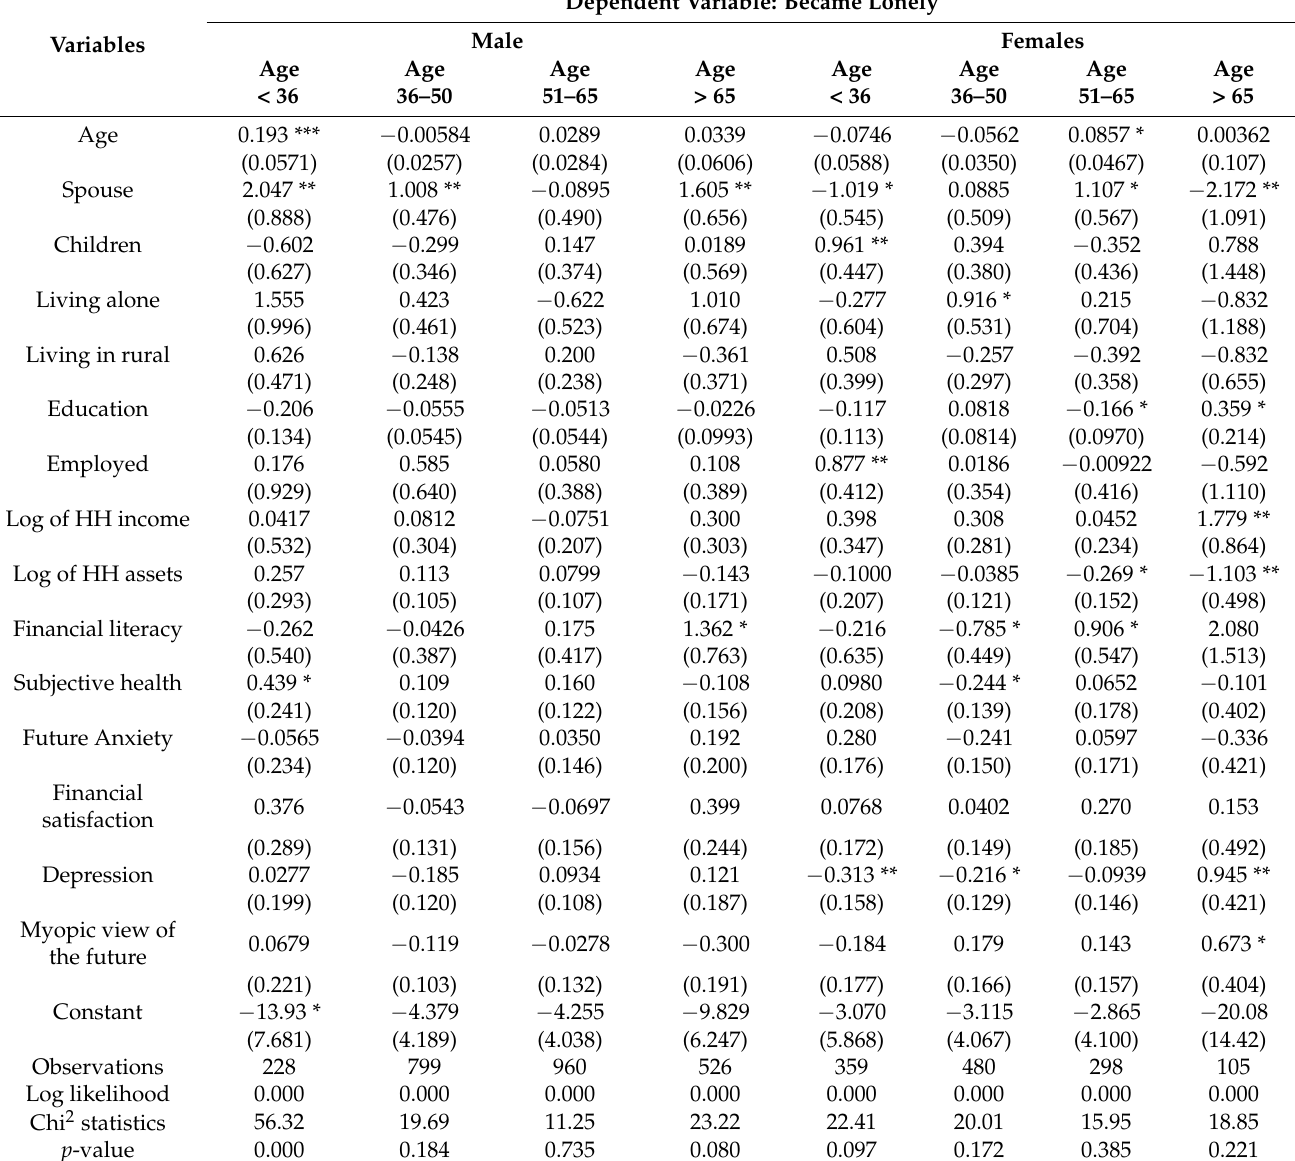
Table 8. Logit regression results of becoming lonely in 2021 (subsample analysis: gender and age